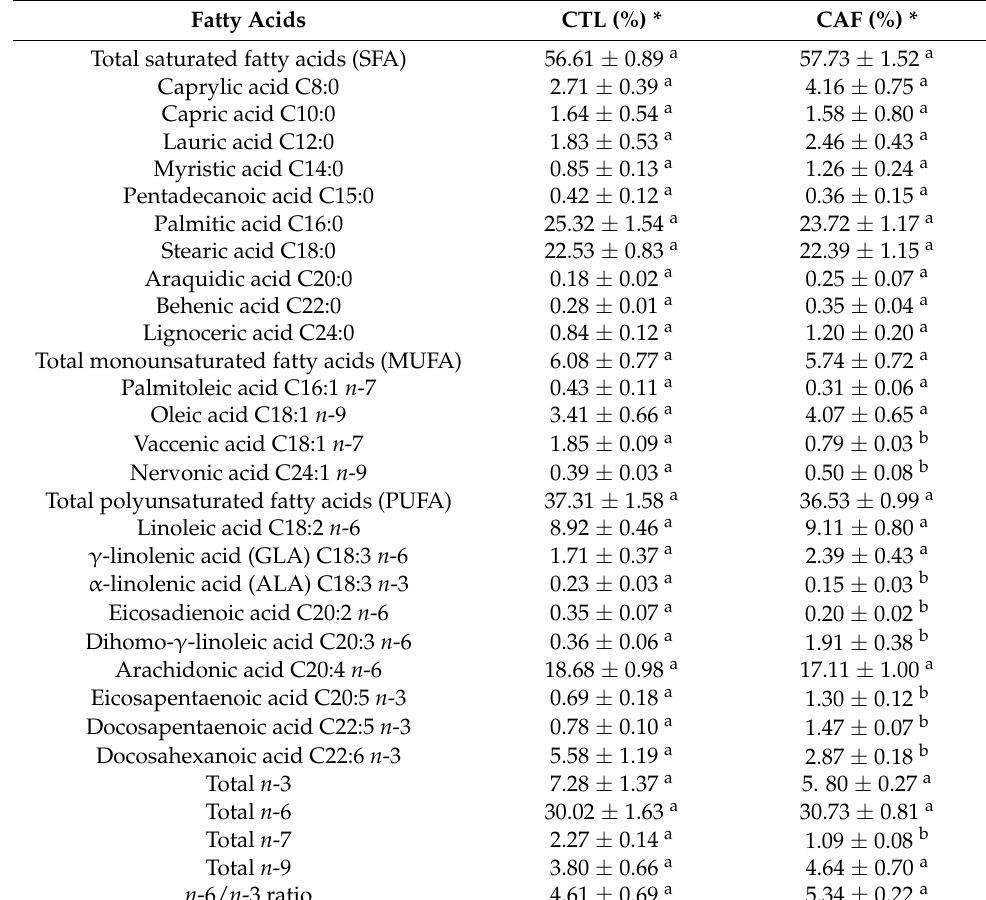
Table 4. Serum fatty acid profiles of phospholipid fraction of male Wistar